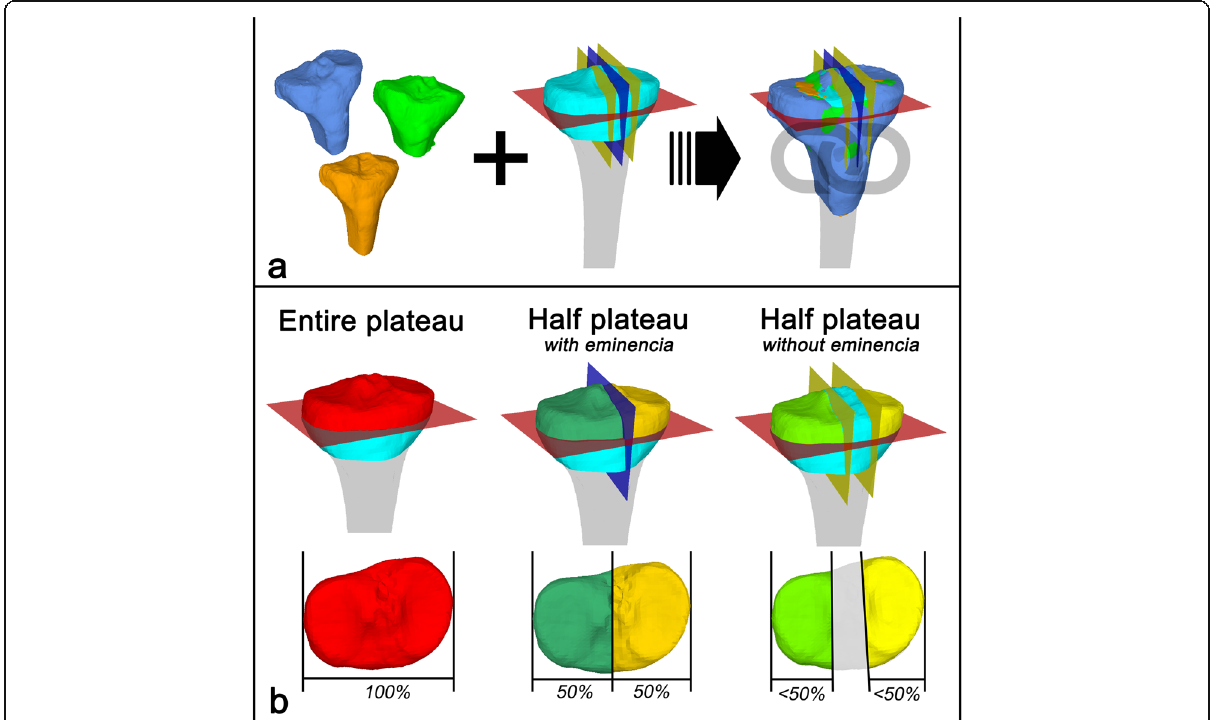
Fig. 4 Creation of the different predefined 3D models of the tibia plateau. a Different proximal tibia plateaus (left) are automatically superimposed (right) on the average right tibia template (middle). b Entire plateau = Cutting with the axial cutting plane. Half plateau with eminence = Cutting with the axial and centered sagittal cutting plane. Half plateau without eminence = Cutting with the axial and medial/lateral cutting plane with exclusion of the intertrochanteric